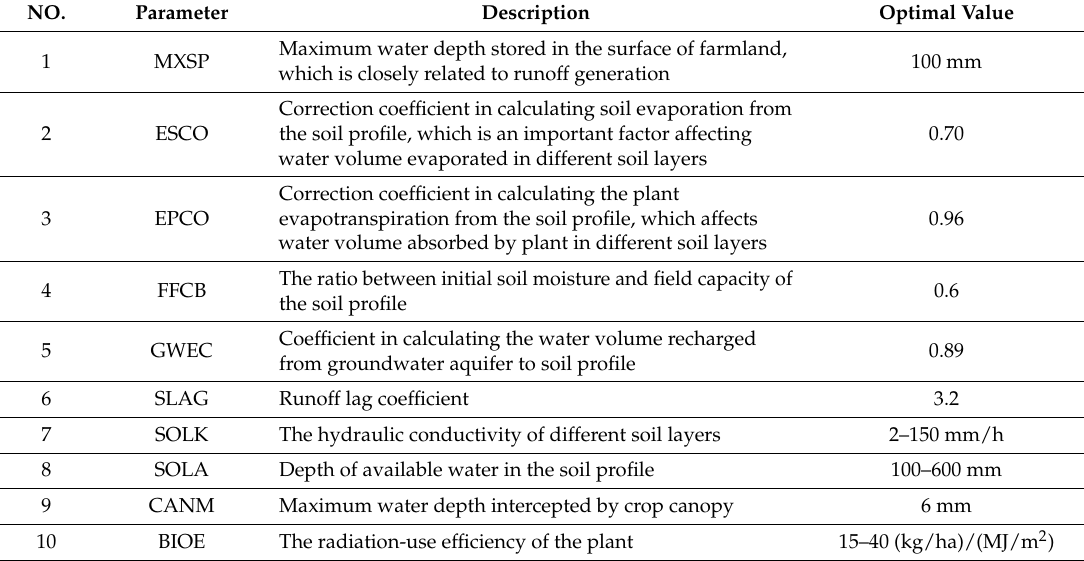
Table 4. Key parameters and their optimal values used in